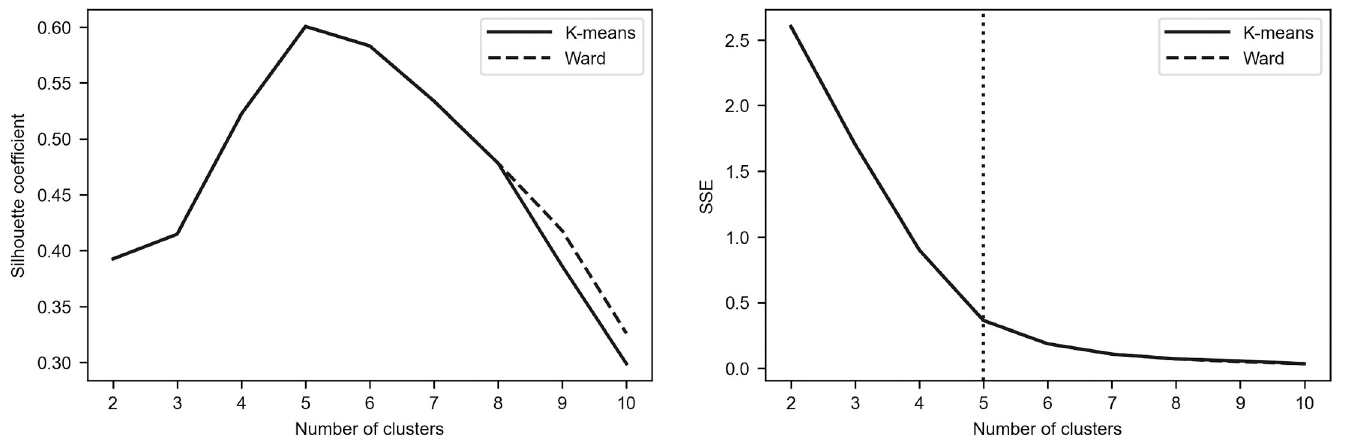
Fig 4. Silhouette coefficients and elbow curve–Period_2b.